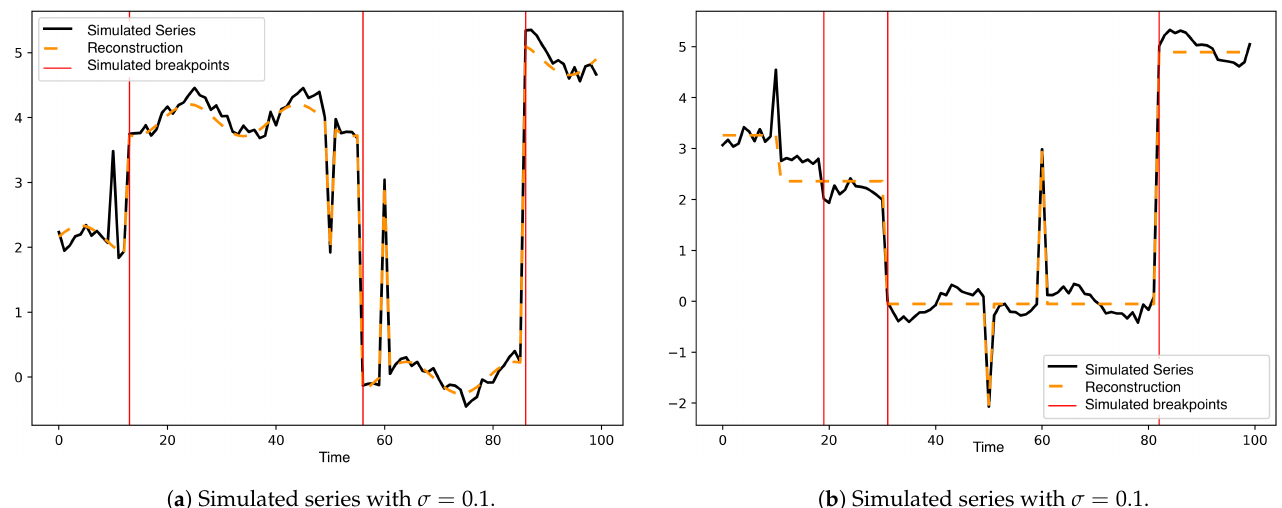
( a ) Simulated series with σ = 0.1. ( b ) Simulated series with σ = 0.1. Figure A1. In ( a , b ), simulated series and adjusted model for standard deviation σ =